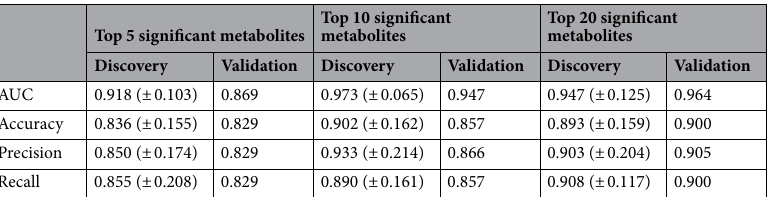
Table 3. Performance of logistic regression models with various biomarkers for discriminating healthy controls and lung cancer patients.